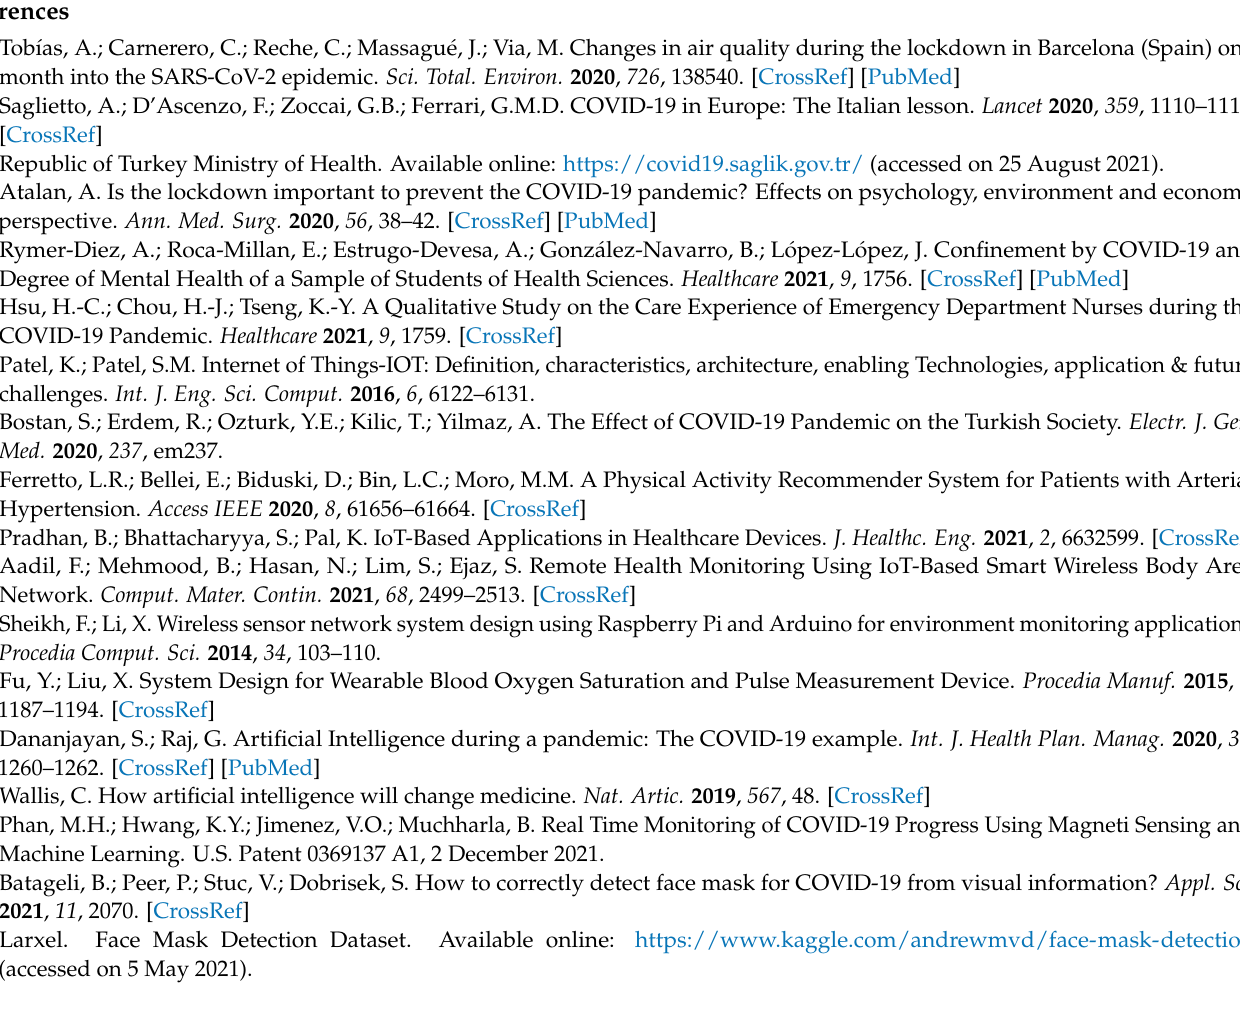
Figure A6. Heartbeat graph on IoT cloud.